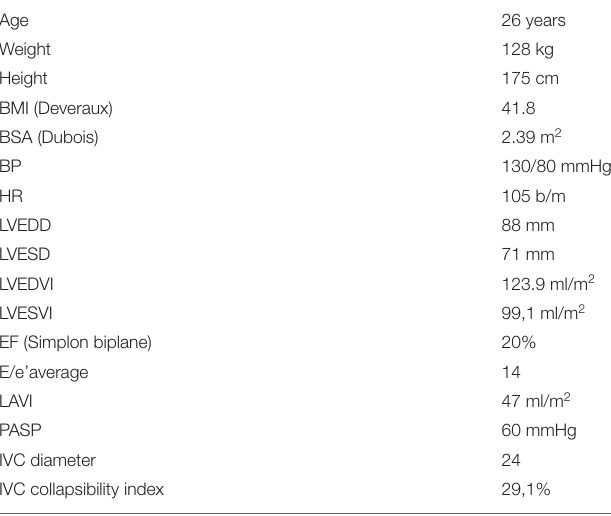
TABLE 1 | Demographic, clinical and echocardiographic characteristic of patient at